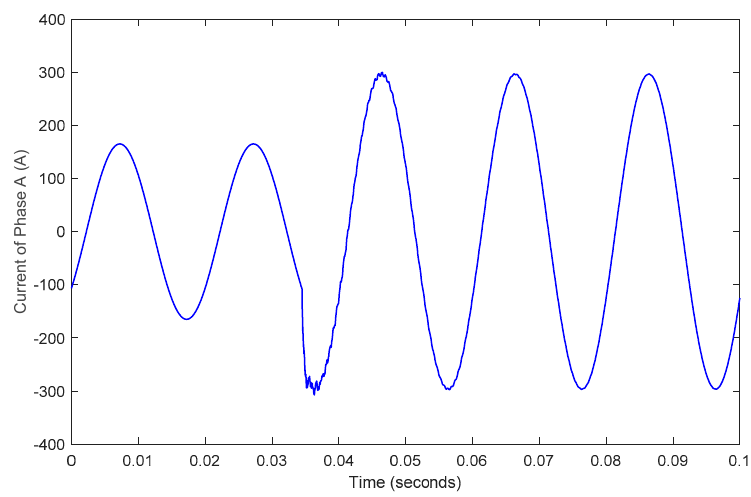
Figure 6. The recorded faulty phase current at the beginning of the feeder (in 21.06 km).